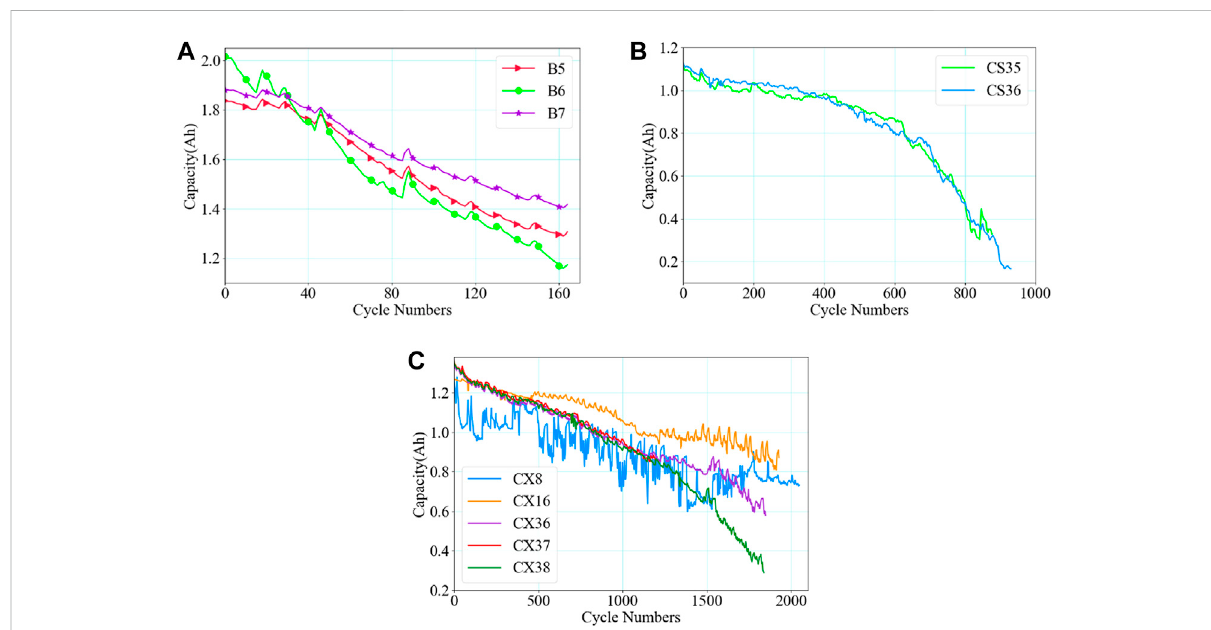
FIGURE 5 Thecapacitydegradationcurvesofthetenbatteries: (A) therealcapacityofB5,B6,andB7batteriesfromtheNASAdataset; (B) therealcapacity of CS35 and CS36 batteries from the university of Maryland dataset; (C) the real capacity of CX8, CX16, CX36, CX37, and CX38 batteries from the university of Maryland